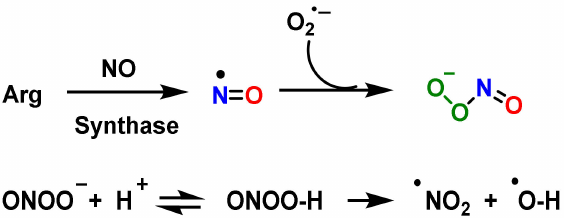
Figure 5. Up: Reaction of radical • NO and anion • O 2 − , producing peroxynitrite. Down: Decomposi- tion of peroxynitrite to • NO 2 and •